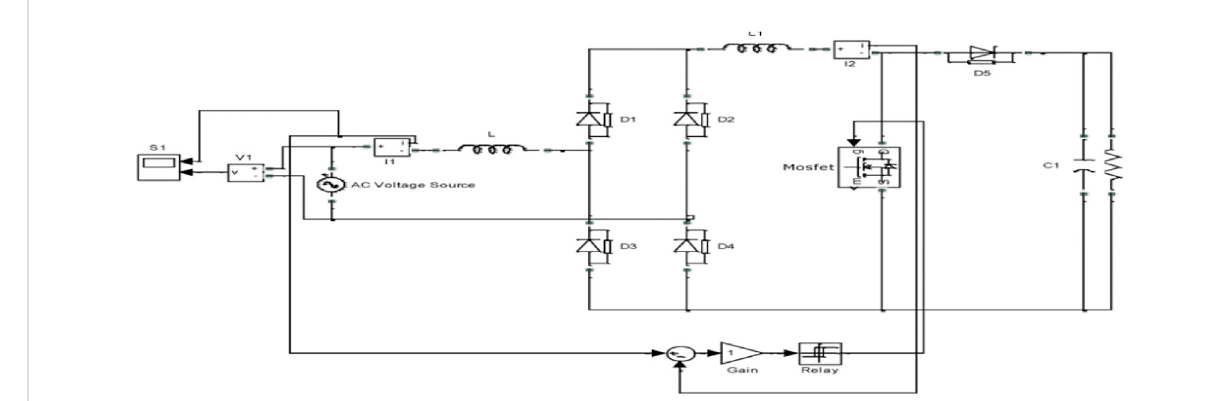
FIGURE 10 PFC boost converter Simulink model.